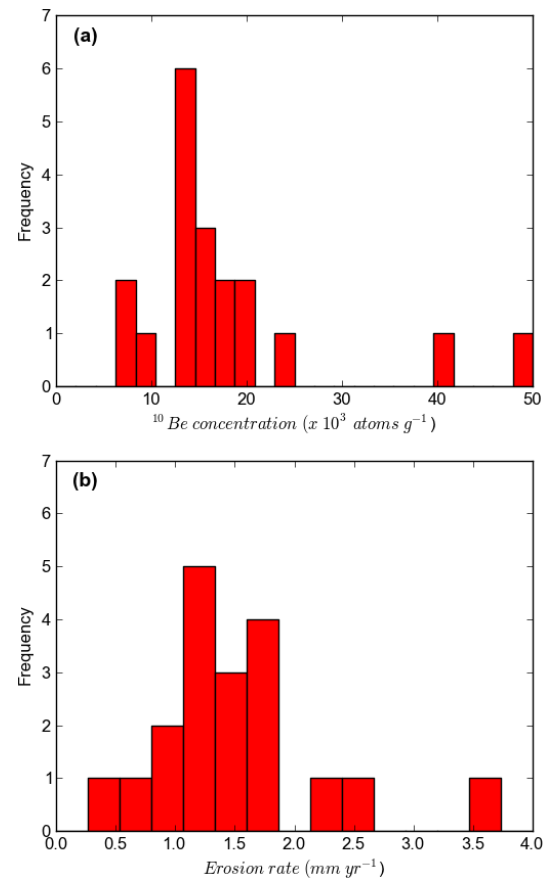
Figure 5. (a) Frequency histogram of mean 10 Be concentrations shown in Fig. 4. (b) Frequency histogram of mean erosion rates calculated using the CAIRN